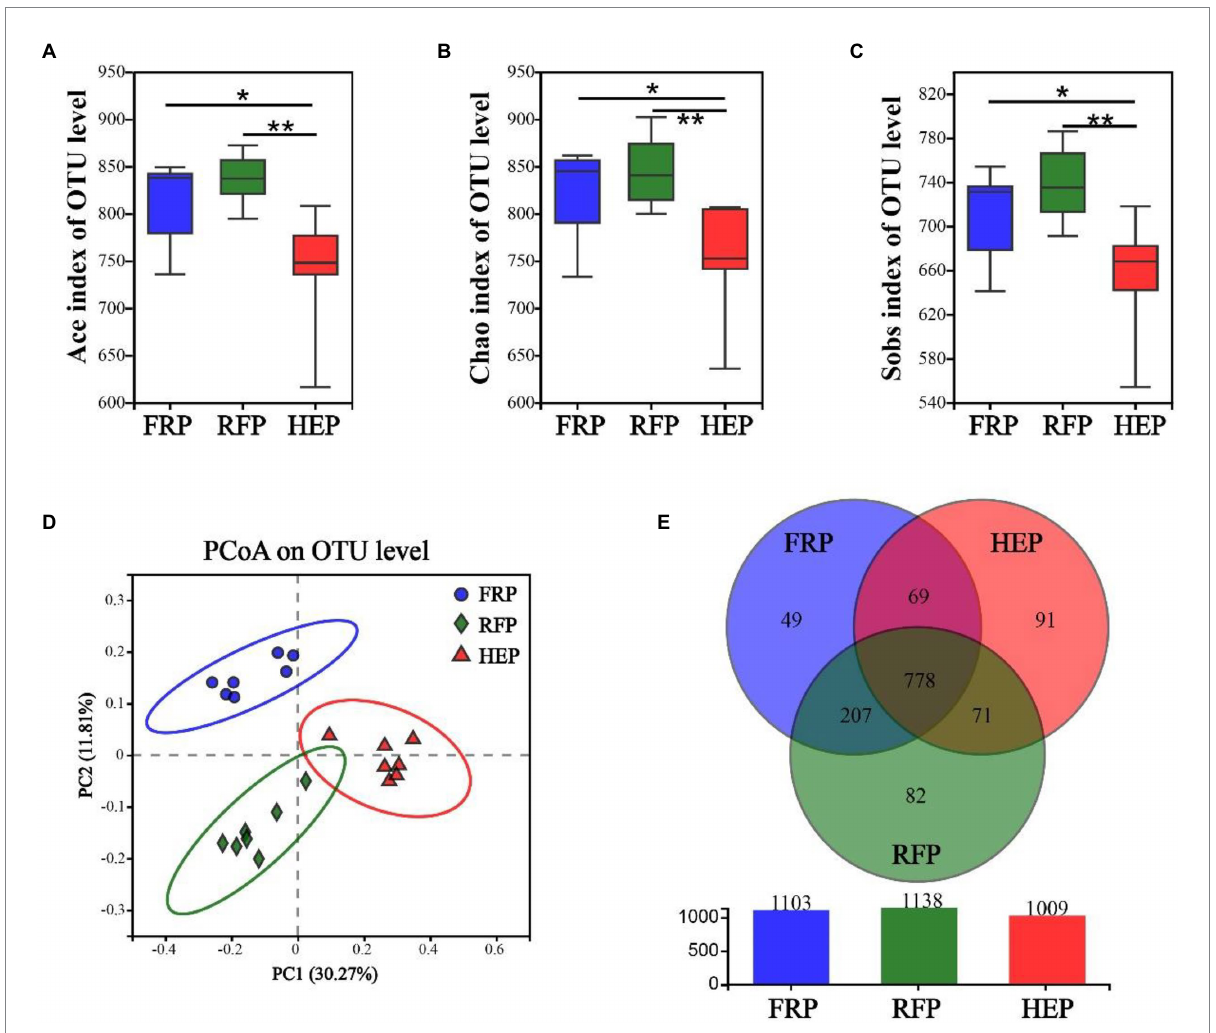
FIGURE 4 Effects of different feeding patterns on gut microbiota diversity of Tibetan pigs. The Ace (A) , Chao (B) and Sobs index (C) of microbiota in cecal chyme. Data are expressed as minimum to maximum ( n = 7). * and ** indicates p <0.05 and p <0.01, respectively. (D) PCoA analysis of microbiota in cecal chyme at the OTU level based on the Bray-Curtis distance. (E) The Venn figure of microbiota in cecal chyme. FRP: free-ranging Tibetan pigs; RFP: feeding the regular Tibetan pig diets; HEP: feeding the high energy content